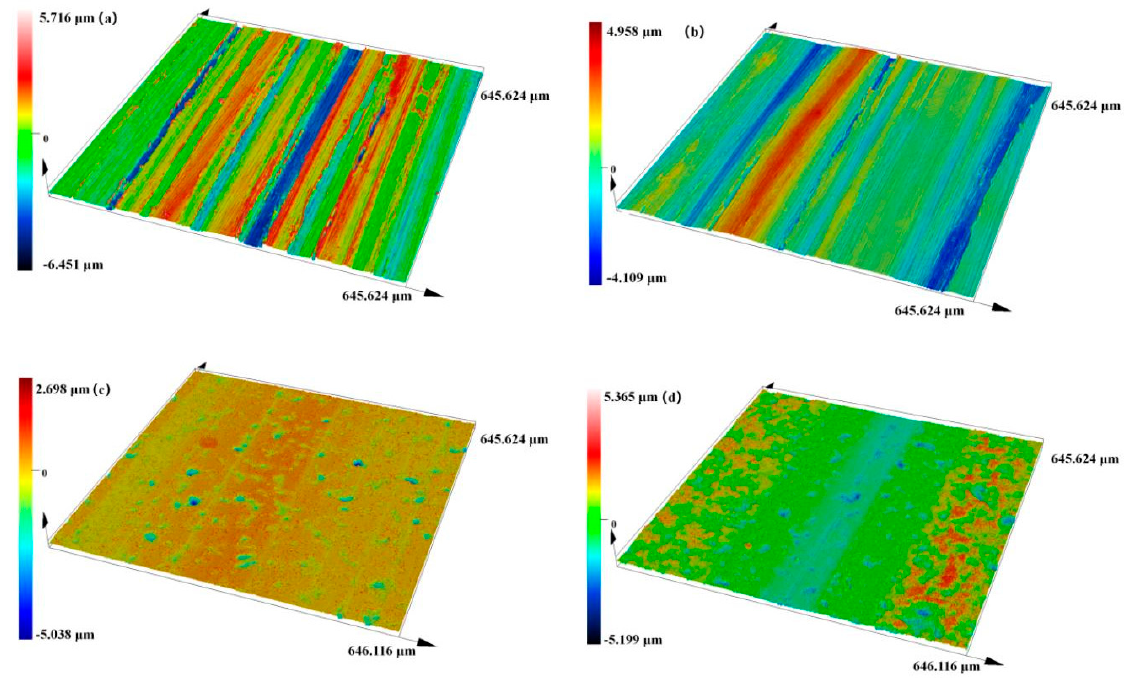
Figure 15. Three-dimensional topography of the worn surface. ( a ) GH group. ( b ) TA group unstructured area. ( c ) NS group. ( d ) NA group unstructured area. Table 4. Characterization of wear surface roughness under di ff erent treatments Sa and Sq.